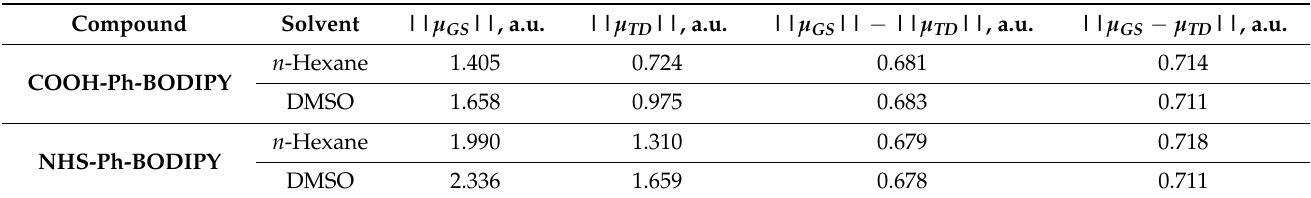
Table 3. Ground S 0 and first excited S 1 total dipole moments || µ GS || and || µ TD || of COOH-Ph- BODIPY and NHS-Ph-BODIPY , difference between their absolute values, and absolute value of their difference in n -hexane and DMSO.